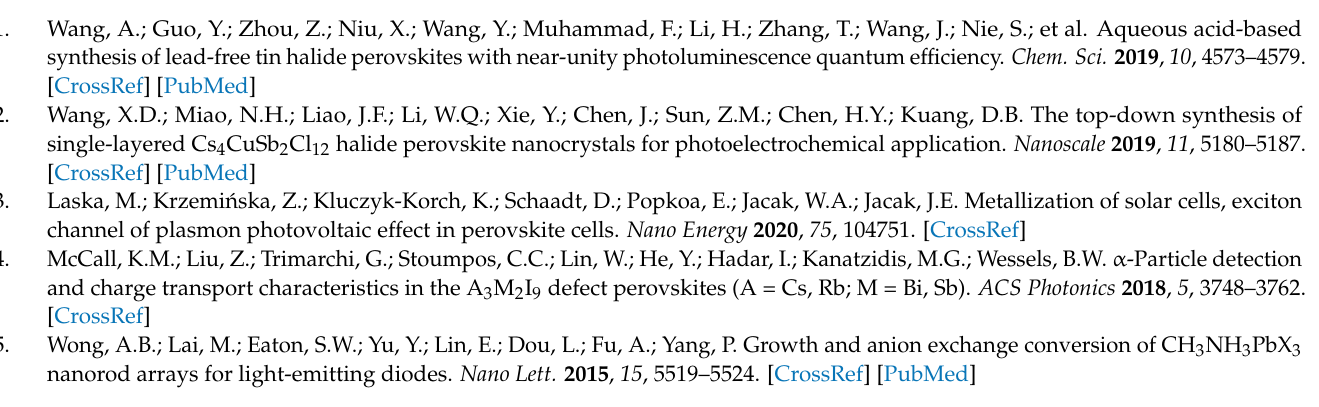
Table S6: Integrating absorption coefficient of Cs 3 Sb 2 X 9 calculated using